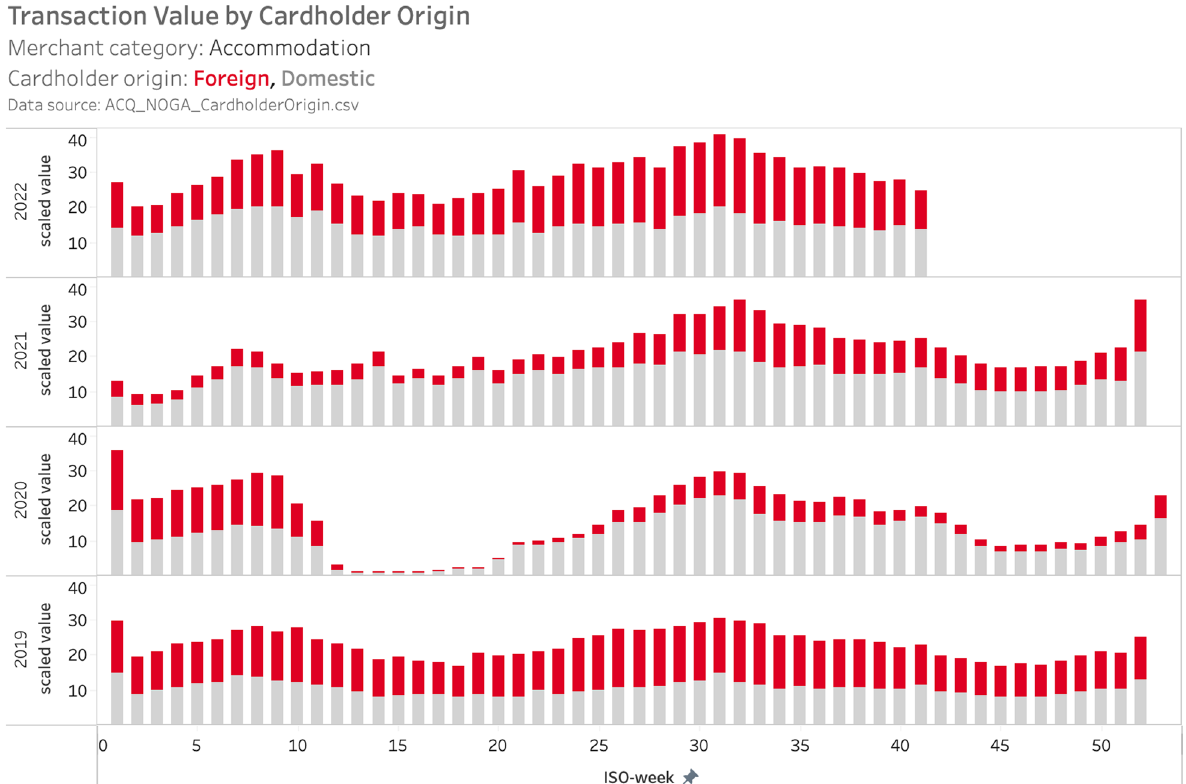
Fig. 9 Weekly spending by domestic vs. foreign consumers on accommodation in Switzerland, 2019–2022. Note : The figure displays scaled total weekly spending with debit cards, credit cards and mobile payments at merchants in the hotel category for 2019–2022 from the acquiring data set. Spending by domestic cardholders/users is reported in gray, spending by foreign cardholders /users is displayed in red. We display the data as provided, i.e., as a scaled value, which preserves the relative interpretability both over time and in the cross-section. See Sect. 2 for further details. Data source: